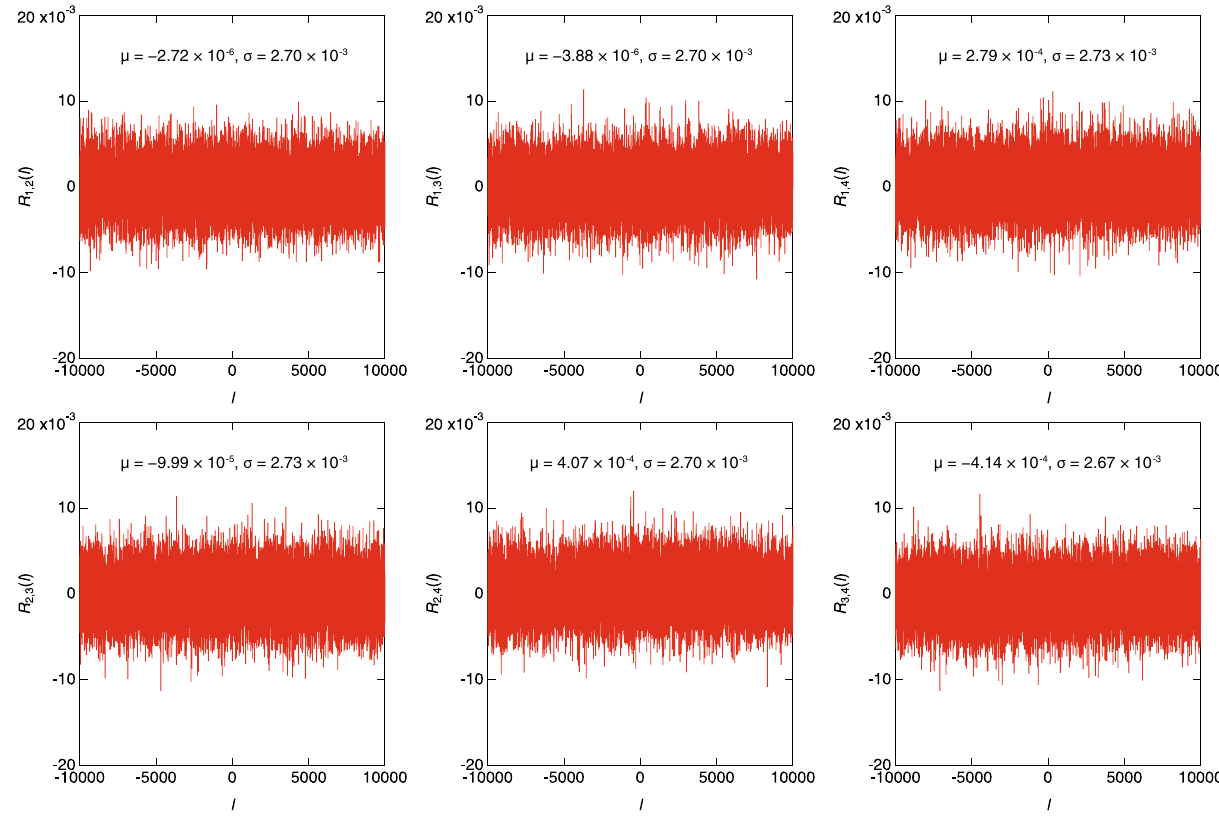
Figure 8. Measured cross-correlation functions between the bitstreams for N = 2 17 . For each cross-correlation function, the average is close to zero and the standard deviation is approximately 2.7 × 10 −3 , which indicates that there is no correlation between the bitstreams generated by